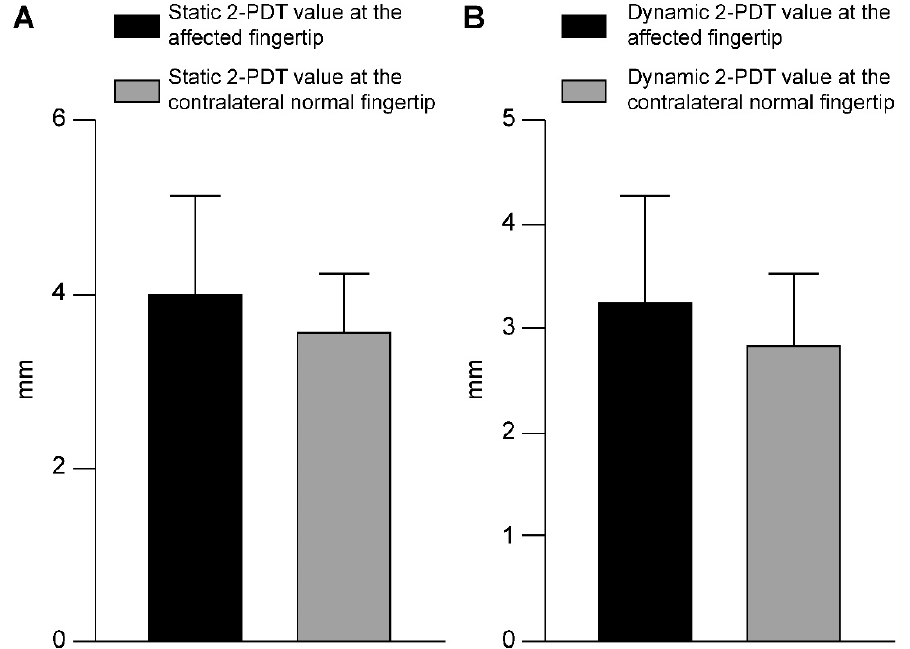
Figure 6. Comparison of mean differences between continuous variables in the two-point discrimi- nation test (2-PDT) data. ( A ) Static 2-PDT. ( B ) Dynamic 2-PDT. tion test (2-PDT) data. ( A ) Static 2-PDT. ( B ) Dynamic